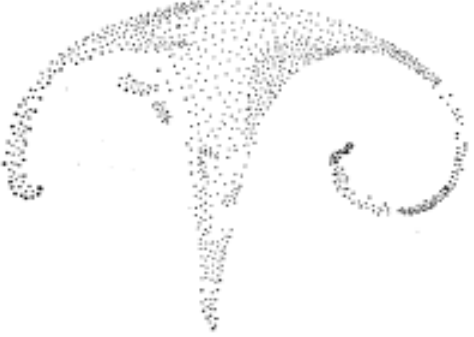
Figure 3. Kef El Baroud images (from de Wailly, 1973/75).